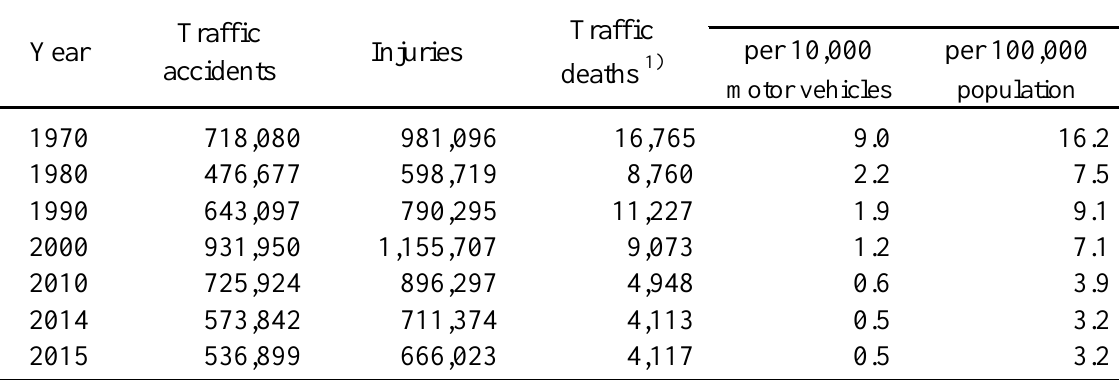
Traffic Accidents and